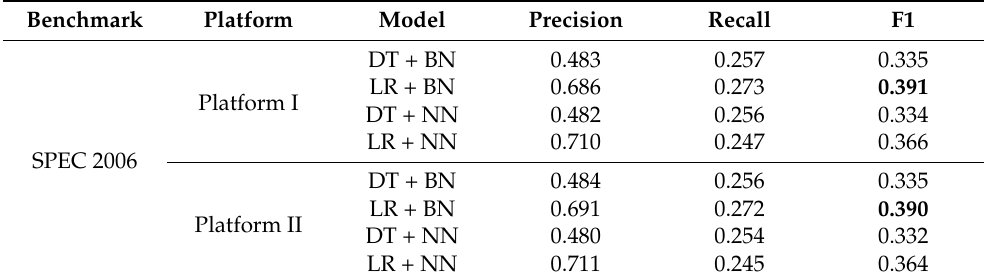
Table 5. Predictive Results of Different Machine Learning Models.